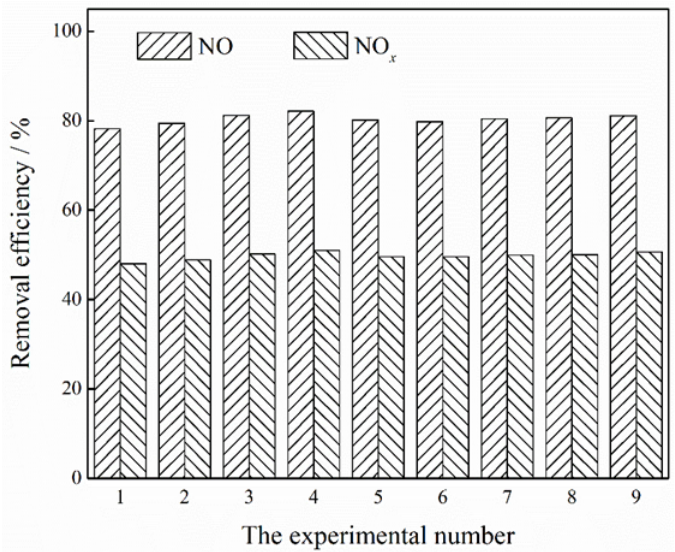
Figure 11. The effect of repetition times on NOx removal efficiency.